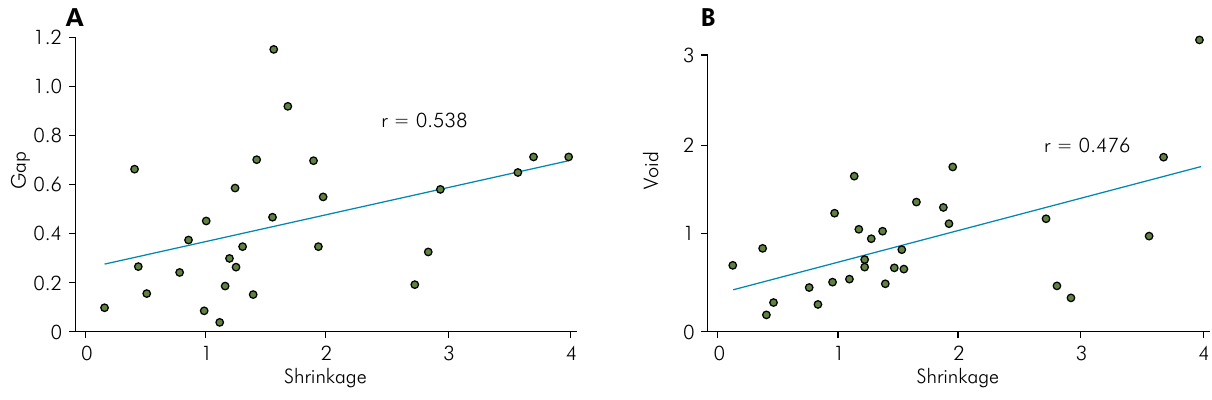
Figure 4. A – Correlation between volume of polymerization shrinkage and final gap in the pulp wall at the resin/tooth interface (p = 0.003). B – Correlation between volume of polymerization shrinkage and final void (p =